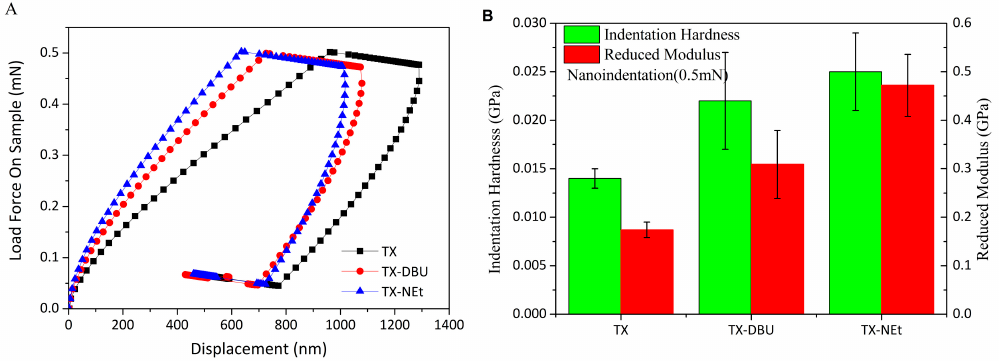
Figure 9. ( A ) Load-displacement curves, and ( B ) reduced modulus and nanoindentation hardness of films subjected to photocuring initiated by the PBGs.